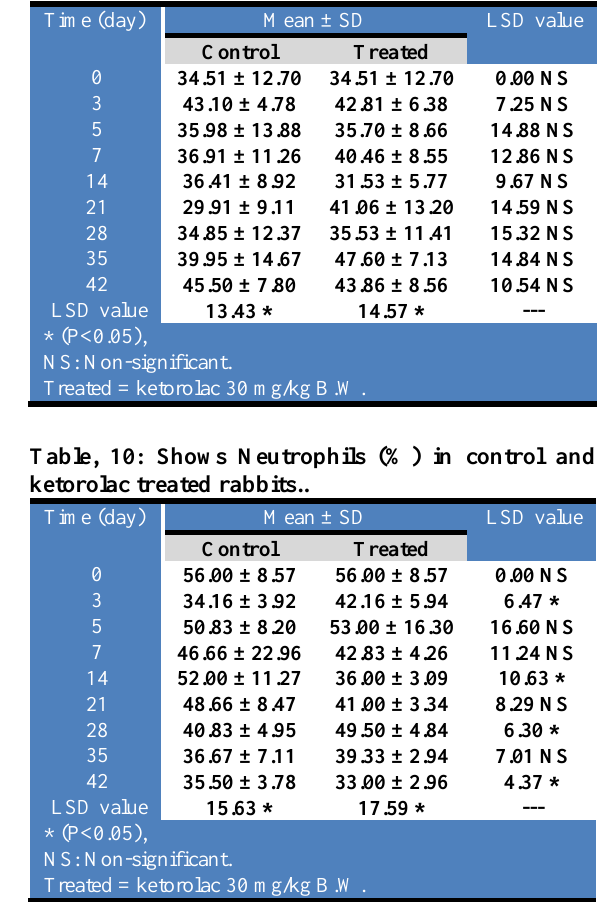
Table, 9: Shows Lymphocytes (%) in control and ketorolac treated rabbits.